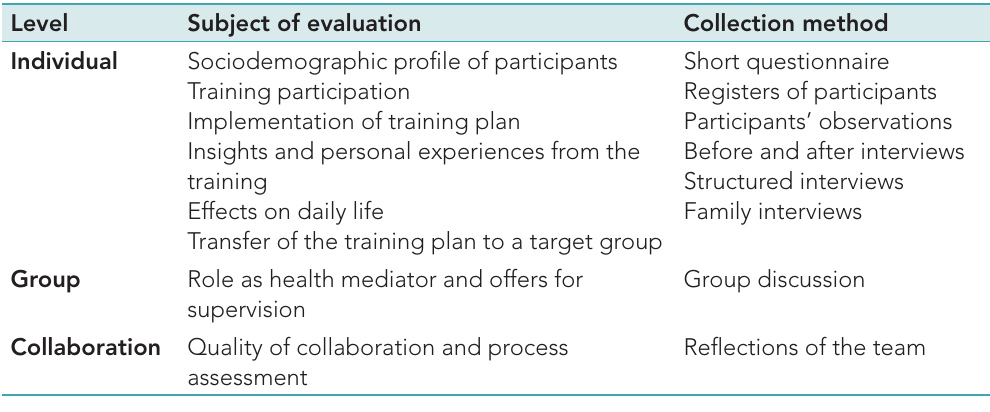
Table 1: Overview of evaluations used at each evaluation level